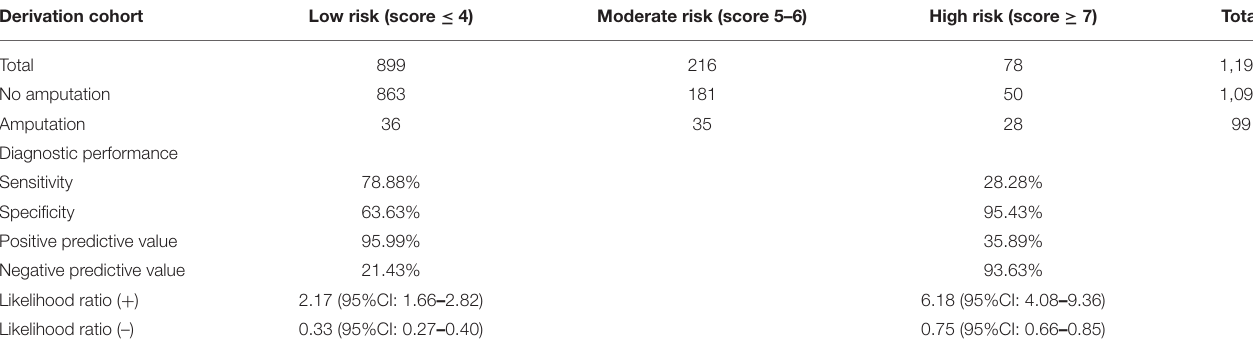
TABLE 4 | Distribution of risk of amputation in patients with necrotizing fasciitis, diagnostic performance, and interpretation in the derivation cohort ( n = 1,193).